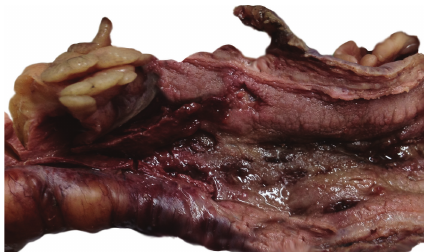
Figure 1: Macroscopic appearance of colectomy material. Mucosa is hemorrhagic and hyperemic; multiple foci of ulcer and perforation areas are seen.